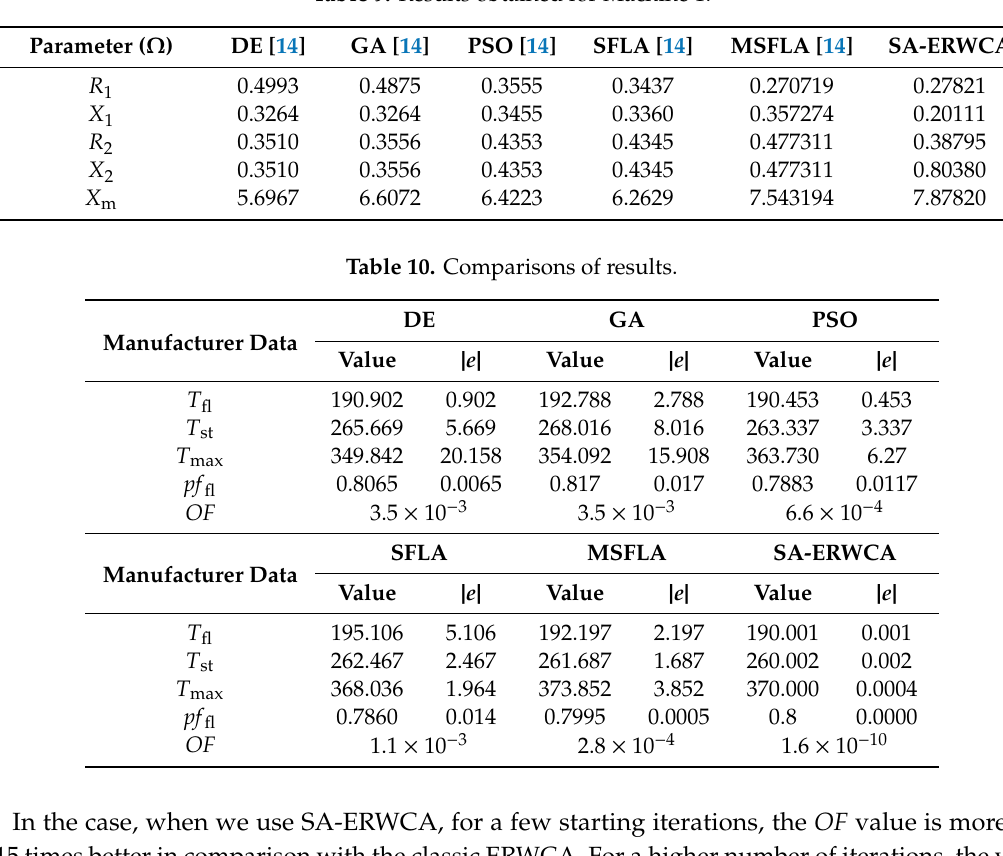
Table 9. Results obtained for Machine 1.